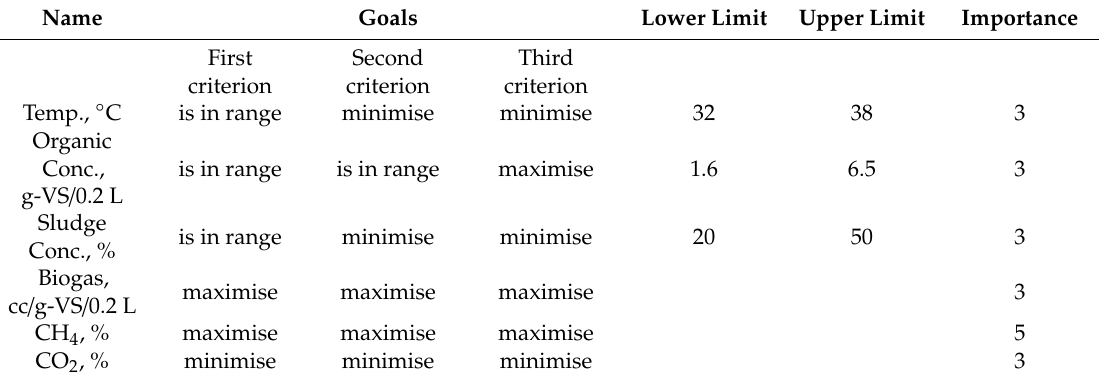
Table 3. Optimisation